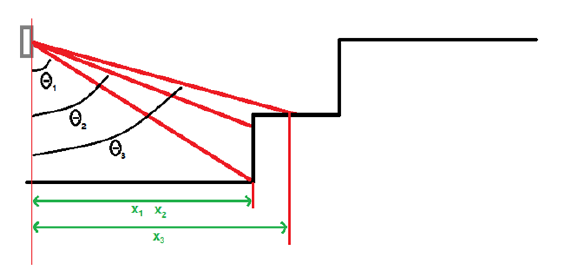
Figure 4. Ascending Staircase Modelling Diagram.